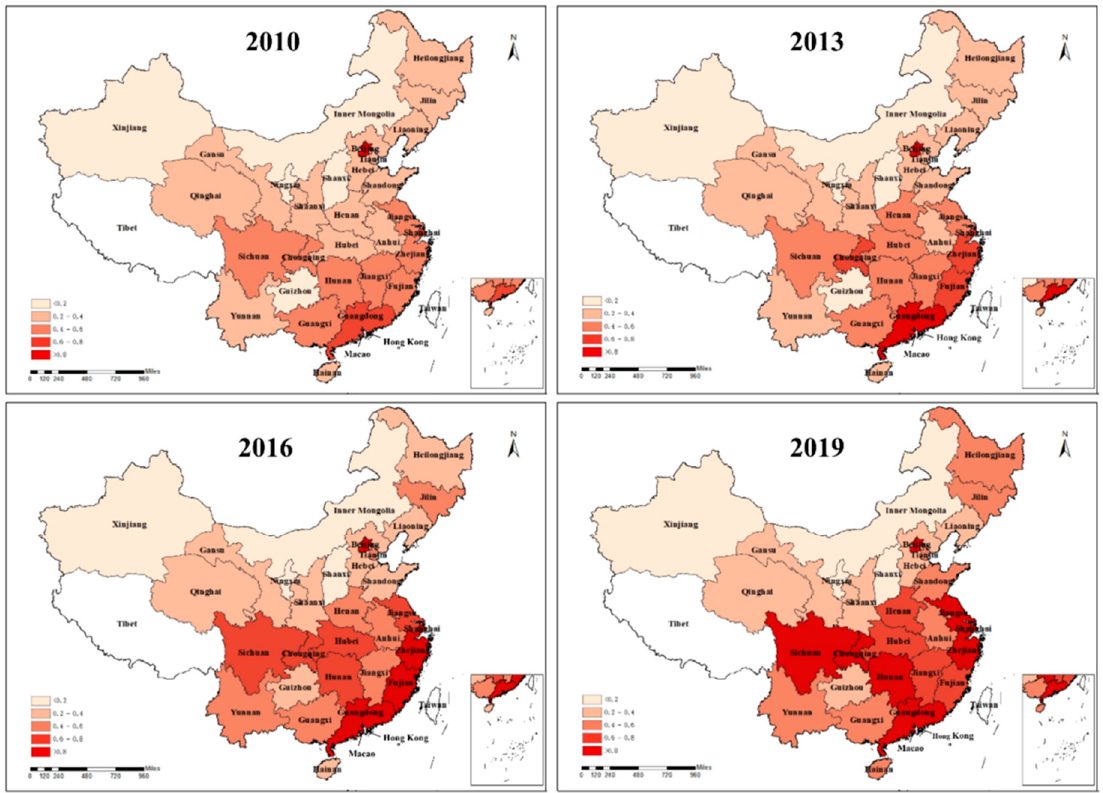
Figure 3. Spatio-temporal variation in carbon productivity in China (2010, 2013, 2016, and 2019).